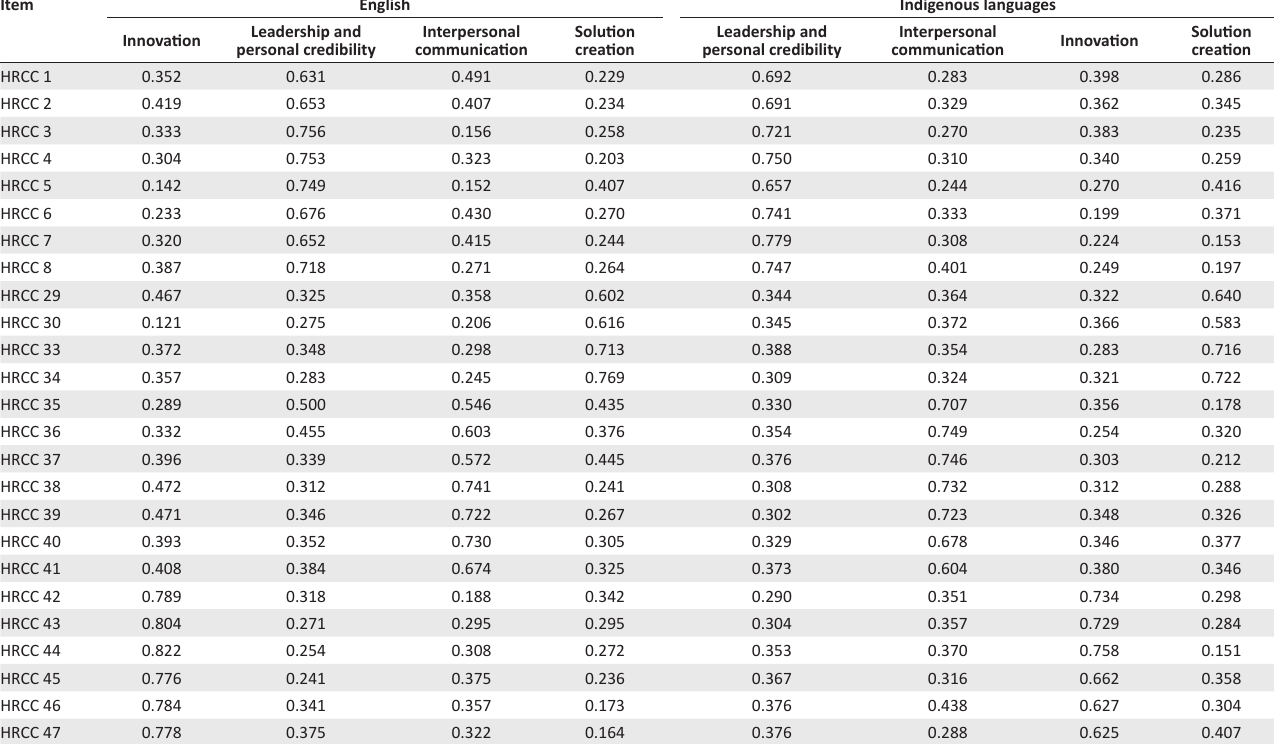
TABLE 1: Rotated component matrix for the Professional behaviour and leadership dimension. Item English Innovation